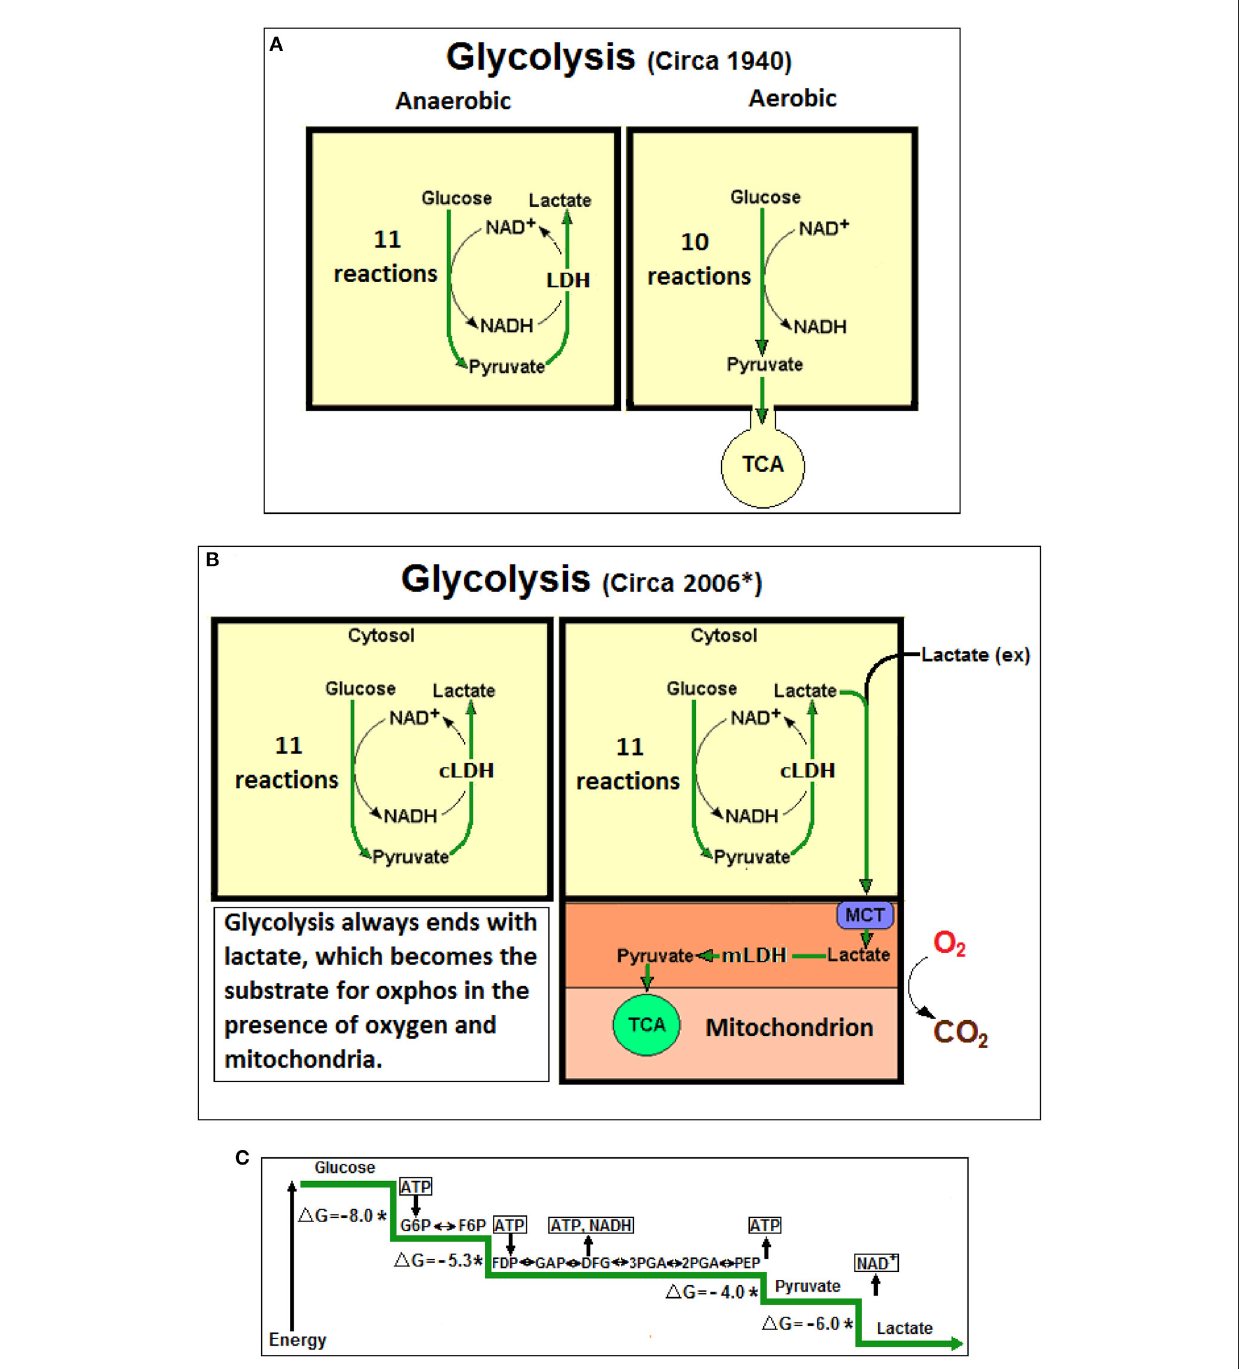
FIGURE1 (A) At the beginning lactic acid (lactate) was considered to be a waste product of anaerobic glycolysis, not produced during aerobic glycolysis (glycolysis, also known as Embden-Myerhof pathway, was elucidated in 1940). The 11-reaction anaerobic glycolysis, shown on the left, ends with lactate and allows the cyclical production of NAD + from NADH. The 10-reaction aerobic glycolysis, shown on the right, ends with pyruvate, to be used as a substrate of the tricarboxylic acid (TCA) cycle, without any reproduction of NAD + from NADH. (B) Over six decades later (*Schurr, 2006), a unified, 11-reaction glycolytic pathway has been suggested where lactate is always its end-product regardless of the presence or absence of oxygen. (C) A schematic presentation of the glycolytic free energy change through the eleven enzymatic steps of the pathway. The first step of glycolysis, the phosphorylation of glucose to glucose-6-phosphate by hexokinase, produces the largest free energy change ( 1 G = − 8.0 Kcal), the last step, the conversion of pyruvate to lactate by lactate dehydrogenase (LDH) produces the second largest free energy change ( 1 G = − 6.0 Kcal). No mechanism has been offered in over 80 years to explain how the LDH step could be arrested, as one would expected according to the prevailing aerobic glycolysis dogma, which stands against the strongly favorable thermodynamic conditions. NAD + , nicotinamide adenine dinucleotide; NADH, nicotinamide adenine dinucleotide, reduced form; cLDH, cytosolic lactate dehydrogenase (LDH); mLDH, mitochondrial LDH; MCT, monocarboxylate transporter; Lactate (ex), external lactate; ATP, adenosine triphosphate; G6P, glucose 6-phosphate; F6P, fructose 6-phosphate; FDP,